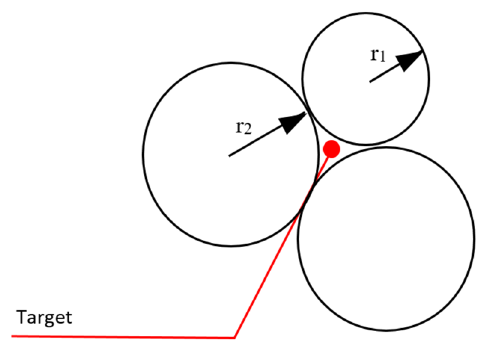
Figure 7. Approach of robots to target point.